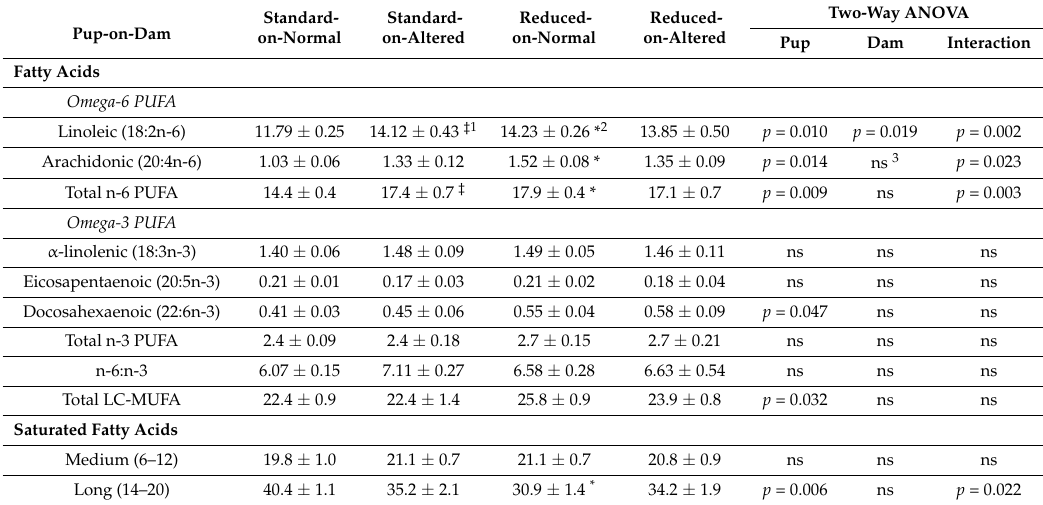
Table 3. Fatty acid composition in stomach contents consumed in milk presented as a cumulative total percentage of fatty acids on postnatal day 6 in the four cross-foster groups ( n = 5–7 per group, with n = 1 representing data from 1 pooled litter). Two-Way ANOVA Standard- Standard- Reduced- Reduced- on-Normal on-Altered on-Normal on-Altered